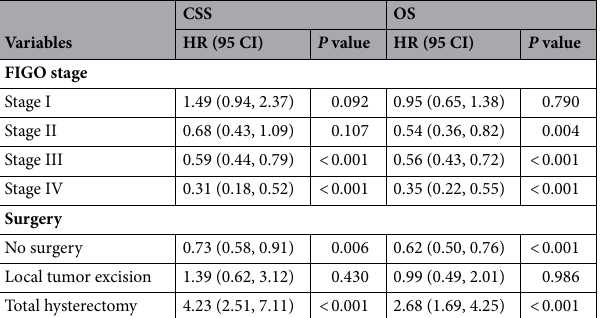
Table 4. Stratified analysis of cancer-specific survival (CSS) and overall survival (OS) for chemotherapy in different FIGO stage and surgery style. Adjustment variables: marital status; age; grade; tumor size; pelvic lymph node metastasis; radiotherapy.